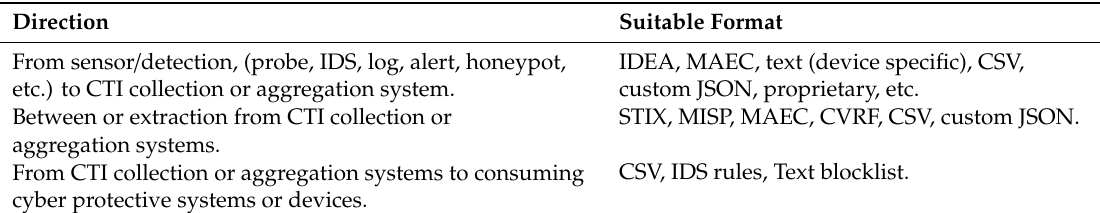
Table 10. Format